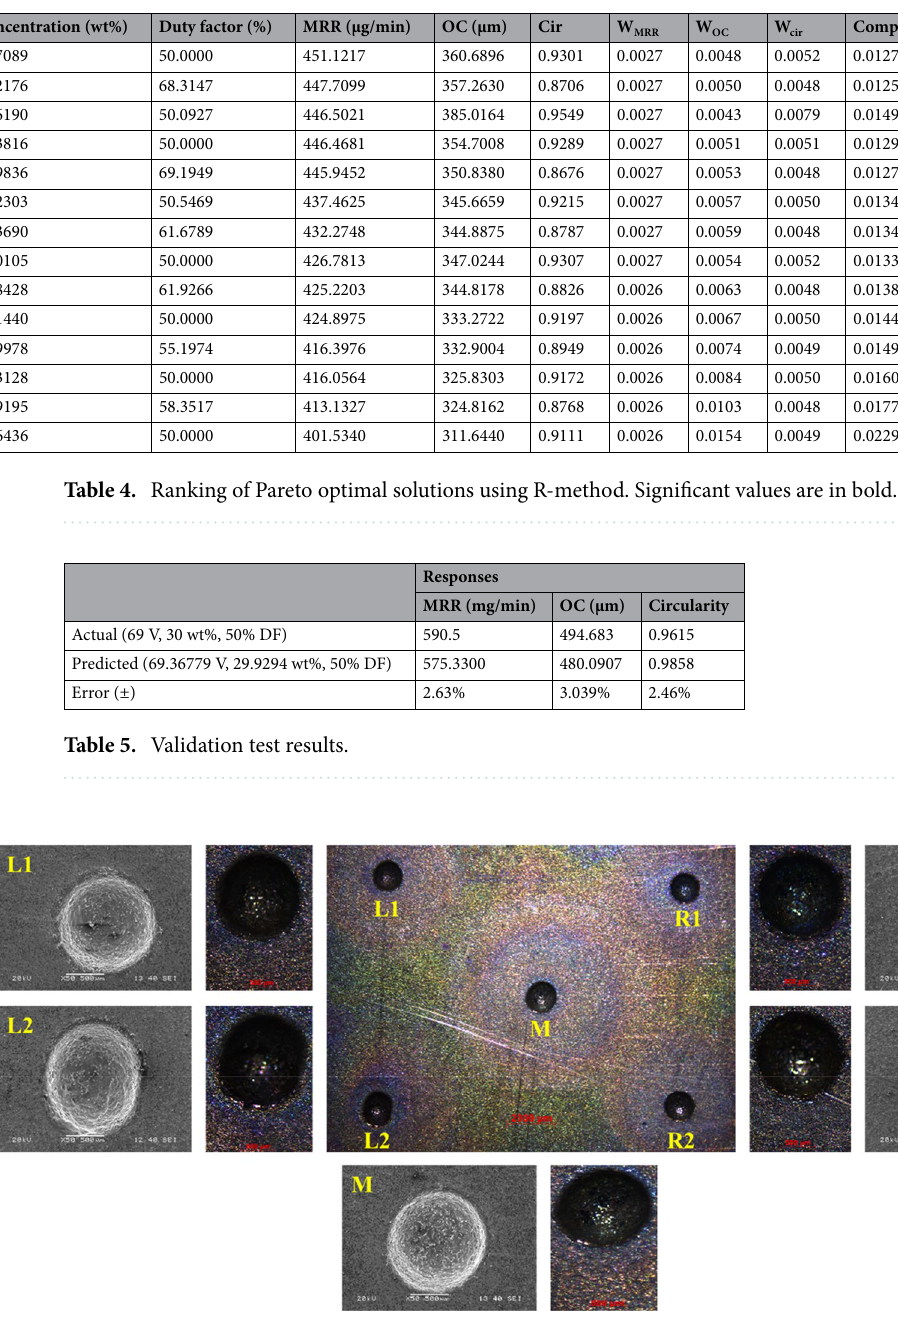
Figure 14. Optical microscope and SEM micrographs of the machined multiple microholes at the optimal process parameter setting of 69 V, 30 wt%, and 50%